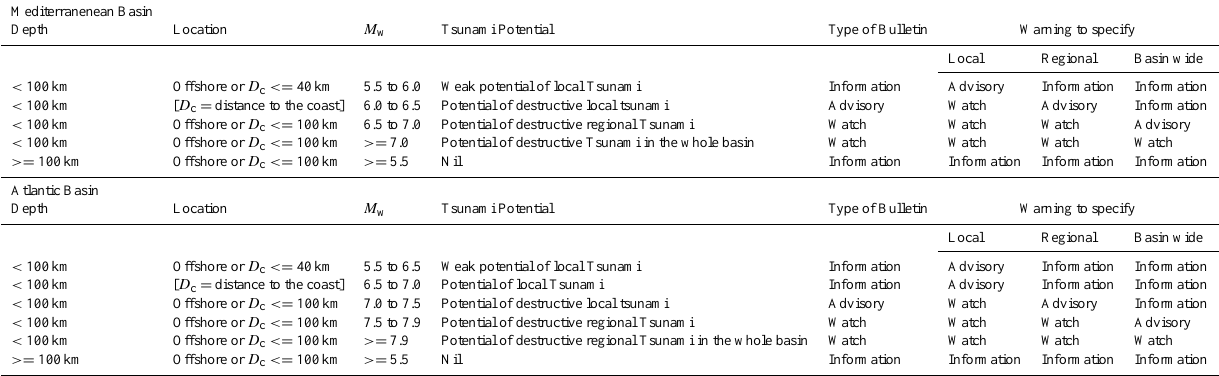
Fig. 9. Geographical location of tsunami sources and fault parameters regionalization compiled by the Joint Research Centre for Tsunami Assessment Modeling System (Annunziato, 2007) in Portugal (L. Matias, personal communication, 2010). GC, GF and AZ represent Gulf of Cadiz, Gloria Fault and Azores zones, respectively. Each dot represents the center of a source location for which 5 earthquake magnitudes scenarios are stored in the precomputed database. Table 2. Decision matrix for the western Mediterranean and NE Atlantic